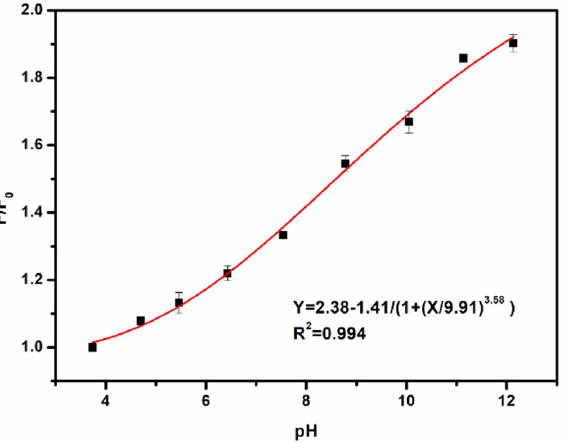
Figure 4. Logistic fit of F/F 0 values of the fluorescence intensity for Fluorescein at different pH (3.7–12.1).